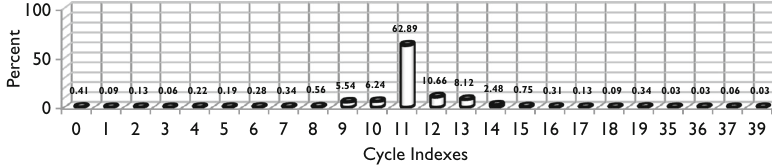
Fig. 2 Index values related to the cycle defined within the region in